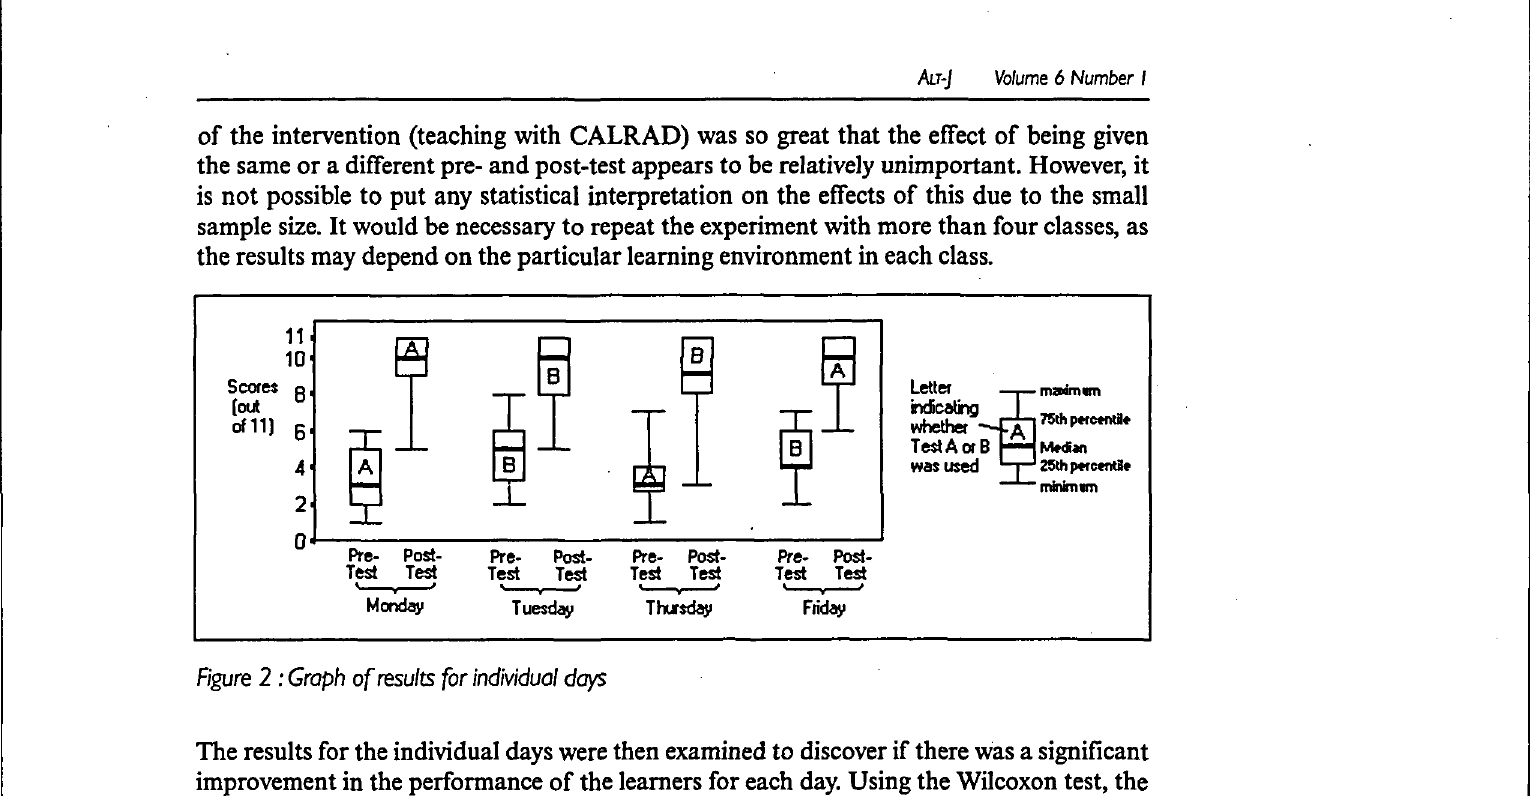
Figure 2 : Graph of results for individual